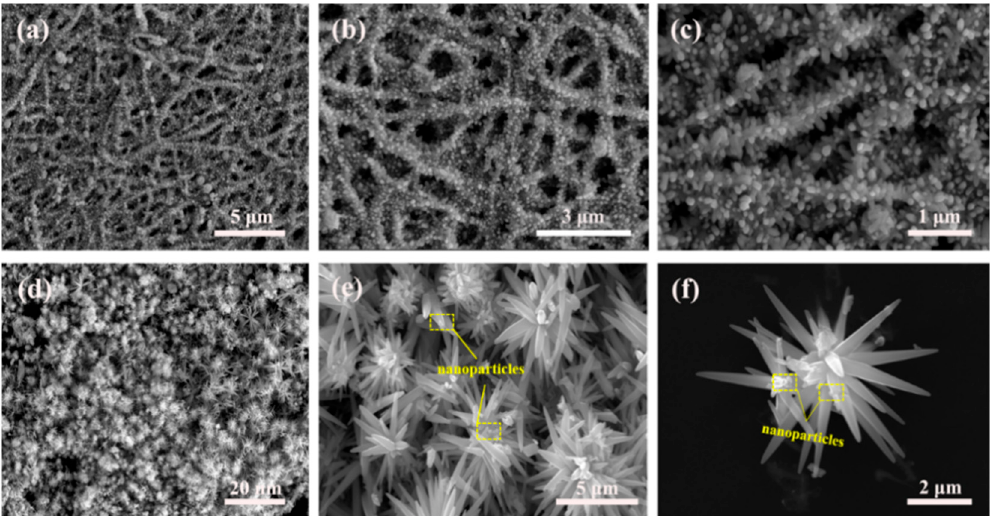
Figure 4. SEM images of as-prepared samples: ( a ) ZnO HS1 in low magnification, ( b , c ) ZnO HS1 with high magnification, ( d ) ZnO HS2 in low magnification and ( e , f ) ZnO HS2 with high magnification.